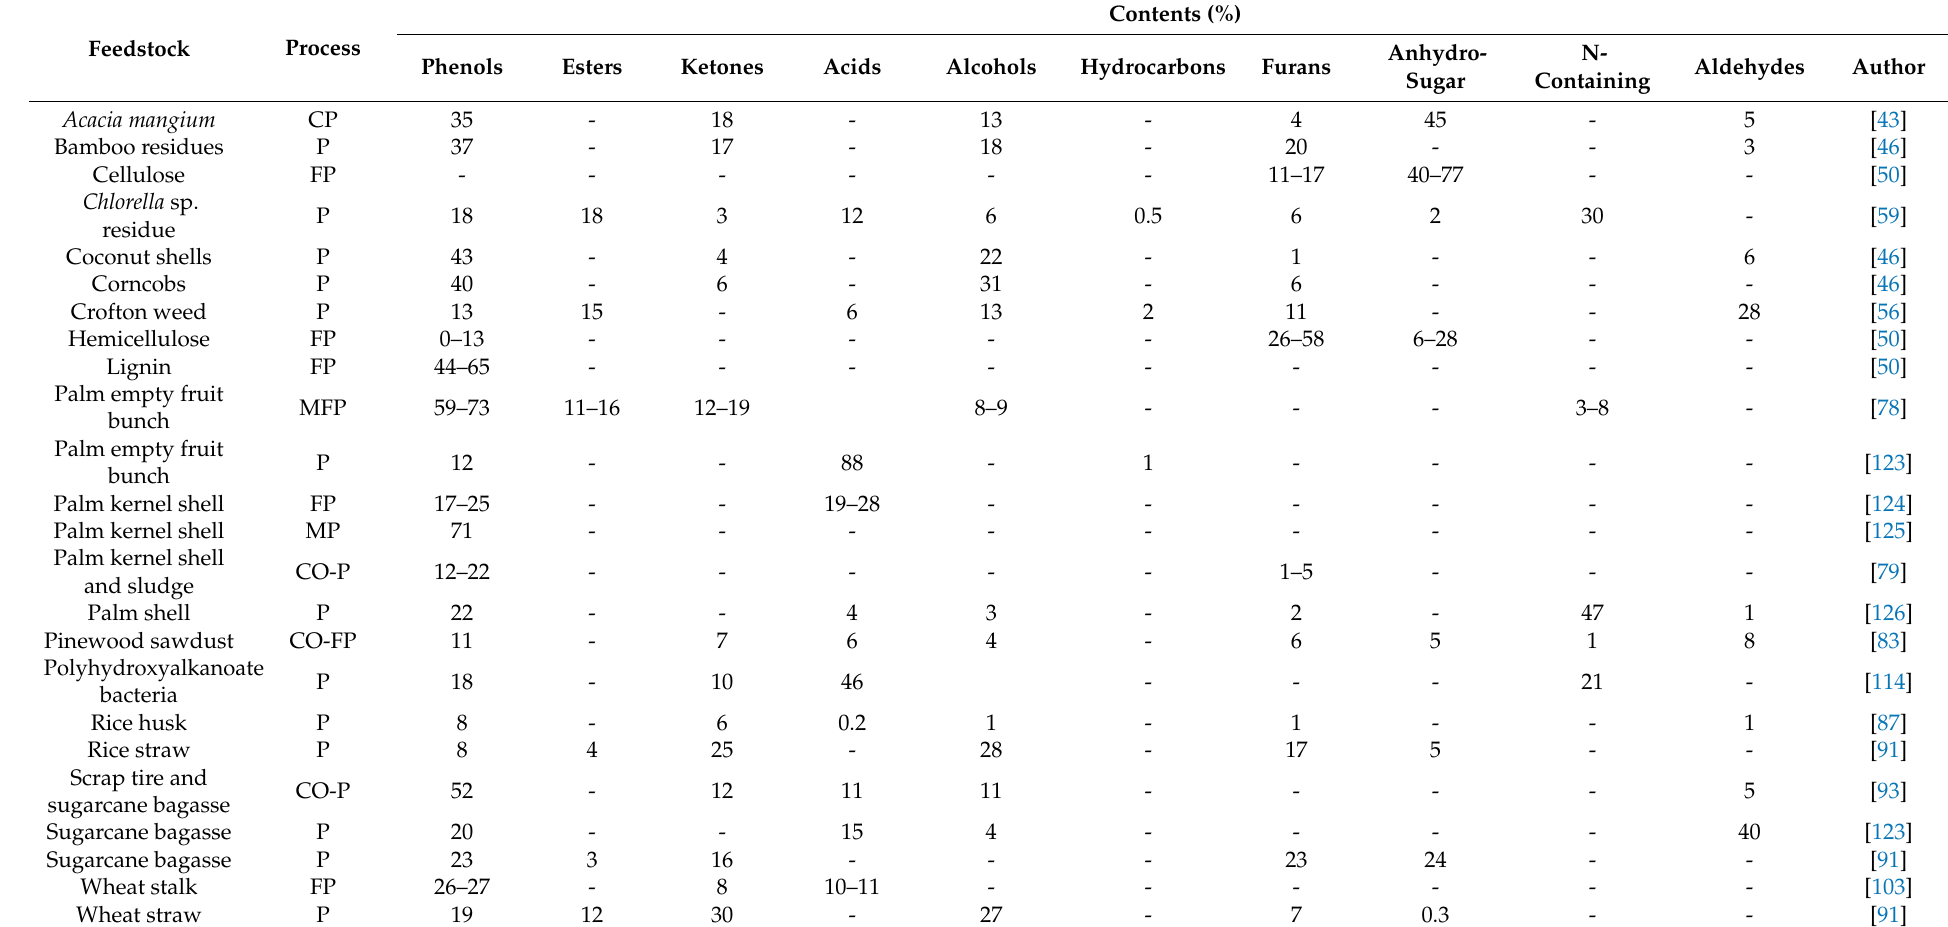
Table 6. Summary of approximate bio-oil compositions from works in Table 2 or others of